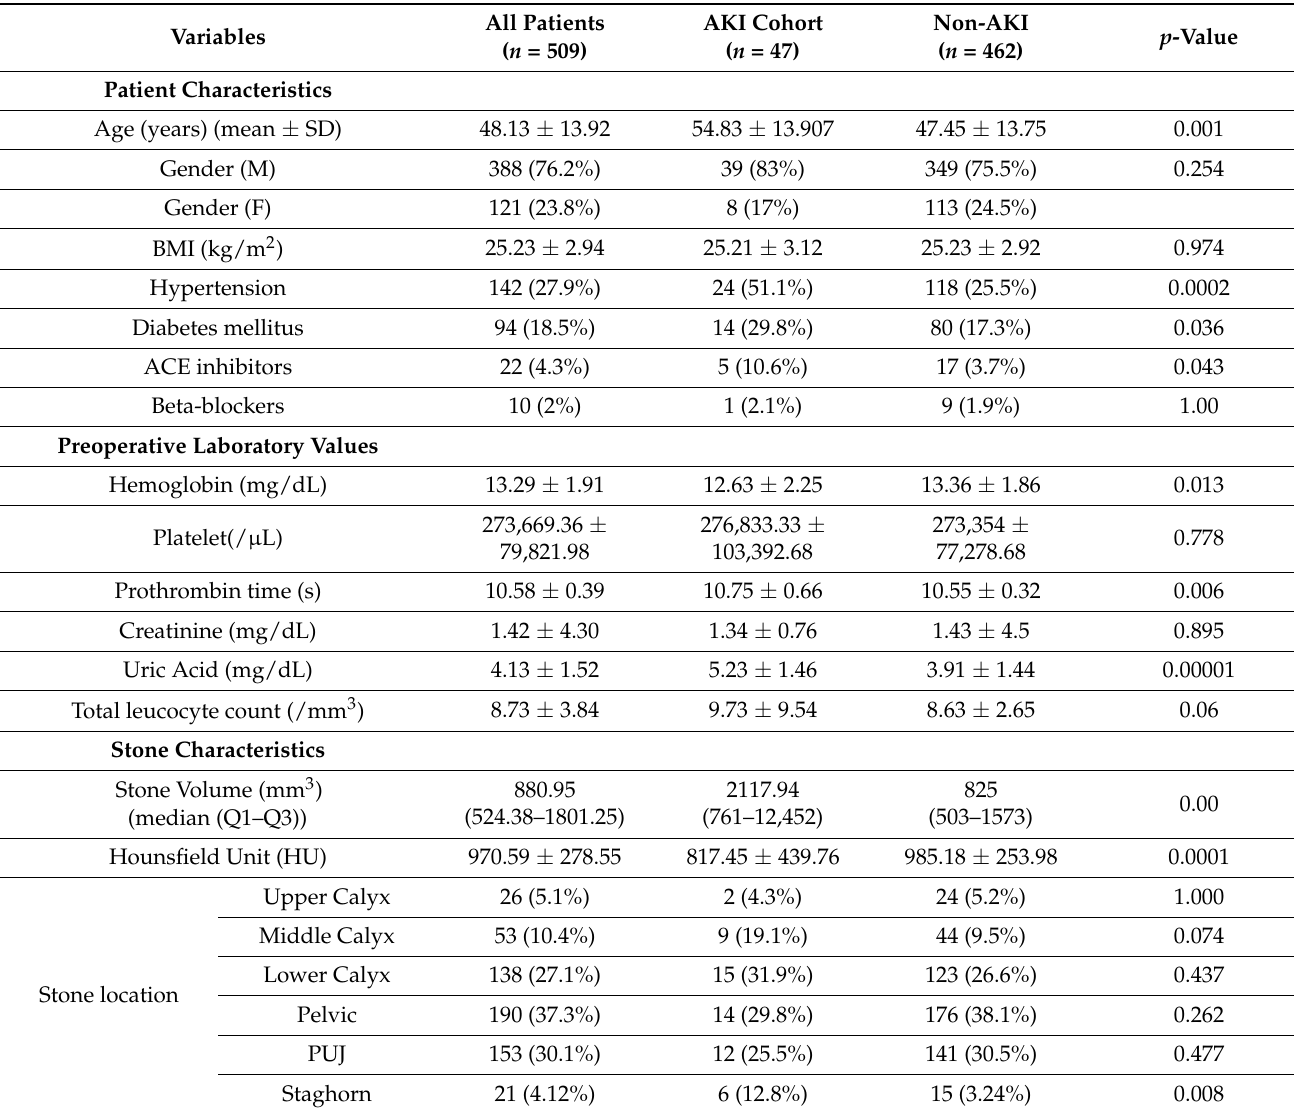
Table 2. Patient characteristics, preoperative laboratory values and stone